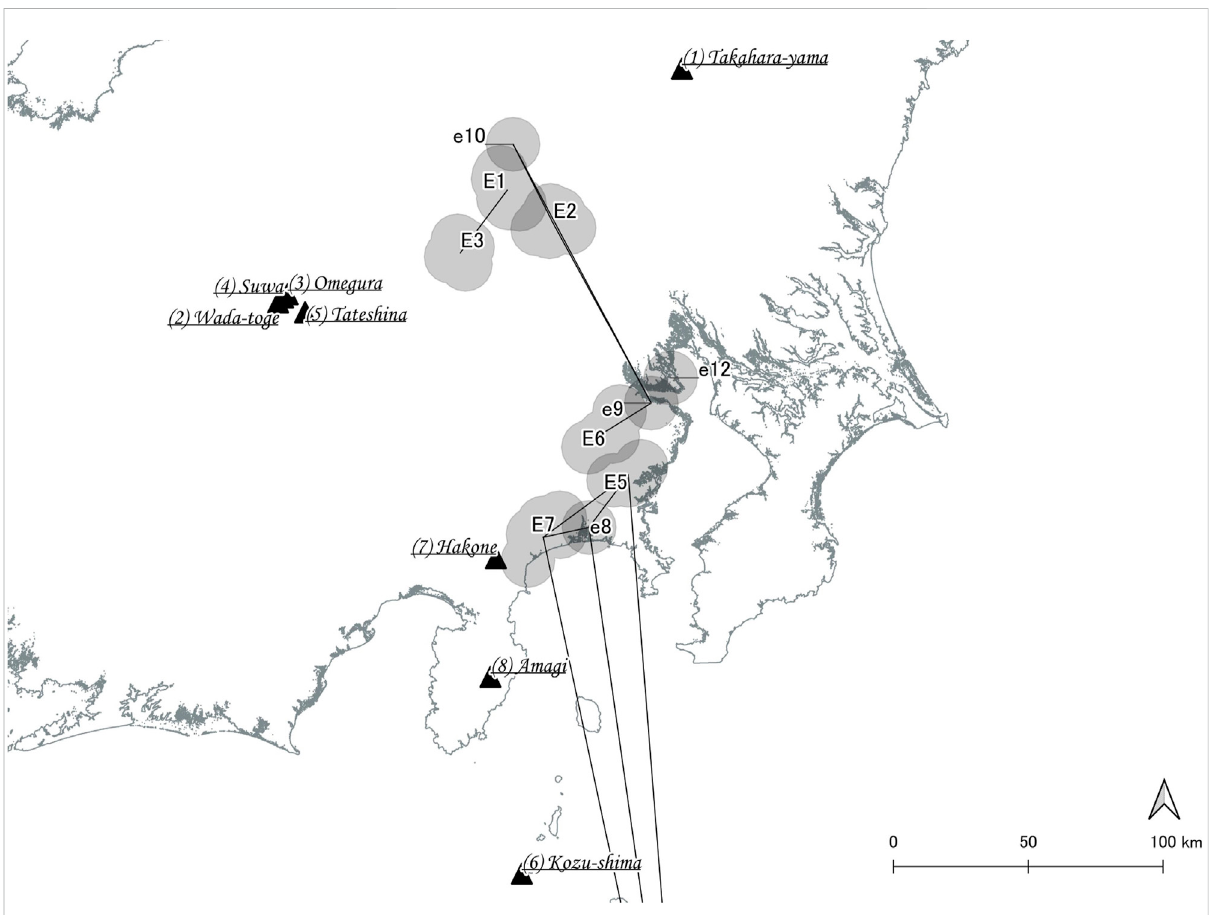
FIGURE 9 Network among consumption areas in Period 2, the early Jomon period (7,000 – 5,500 years cal BP). Clusters are represented by uppercase characters and single sites by lowercase characters. Pairs with a cosine similarity of more than 0.9 in the composition ratio of each provenance area are